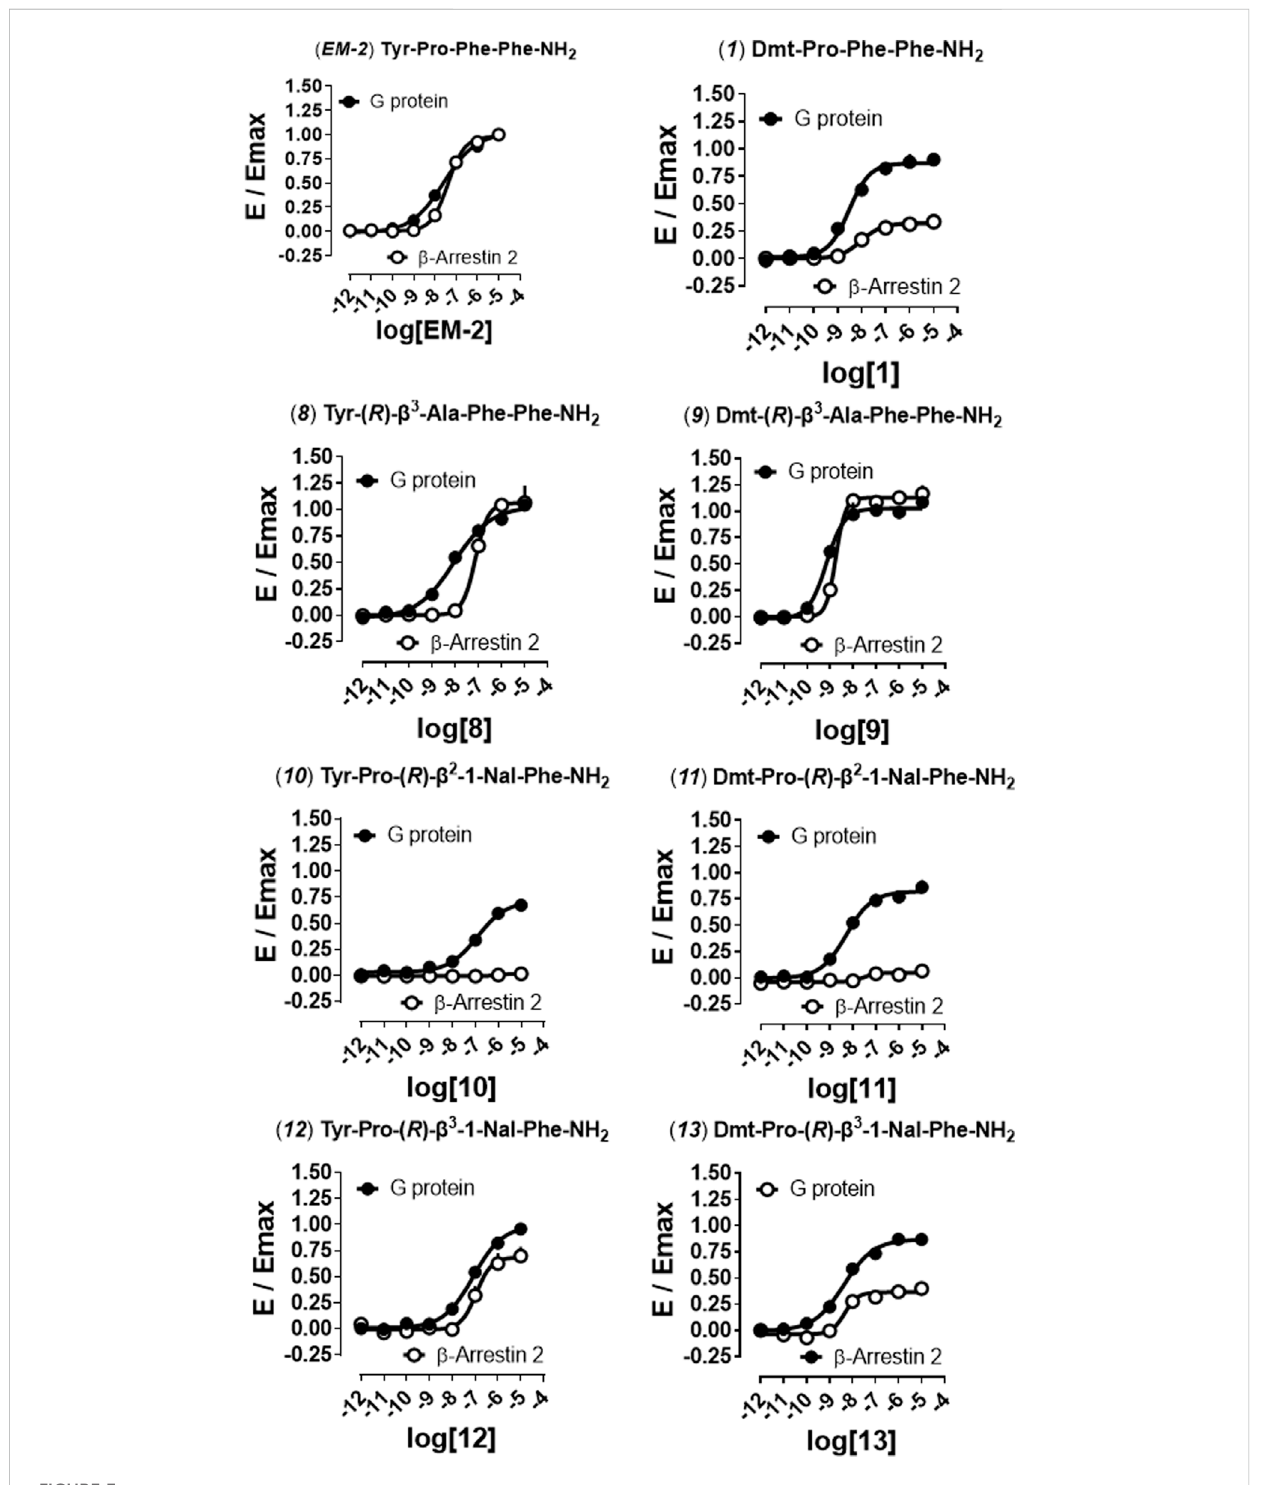
FIGURE 3 Mu receptor-transducer interactions (EM-2,1, 8 – 9). Effects of EM-2 and analog 1 reported for comparison to theactivitiesof analogs 8 , 10 , and 12 , and corresponding Dmt 1 derivatives ( 9 , 11 , 13 ) in mu-G protein and - β -arrestin 2 BRET interaction assays. Data are mean + SEM of at least four independent experiments performed in duplicate. Corresponding bias plots are reported in Supplementary Figure